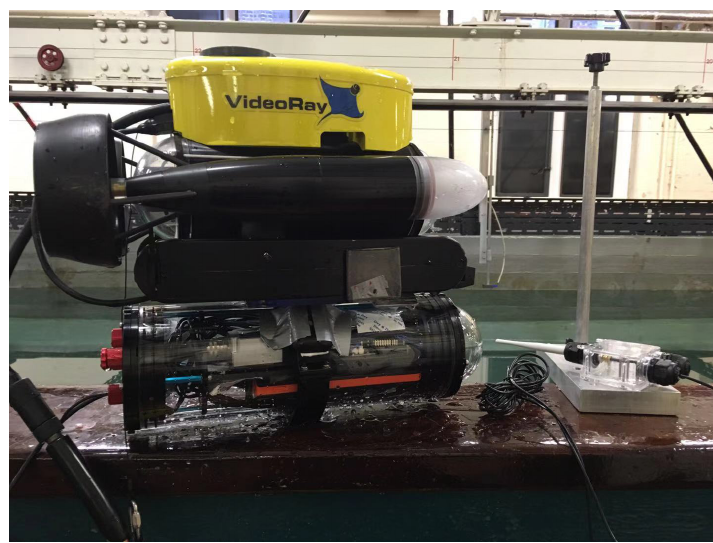
Figure 2. VideoRay Pro 3 with